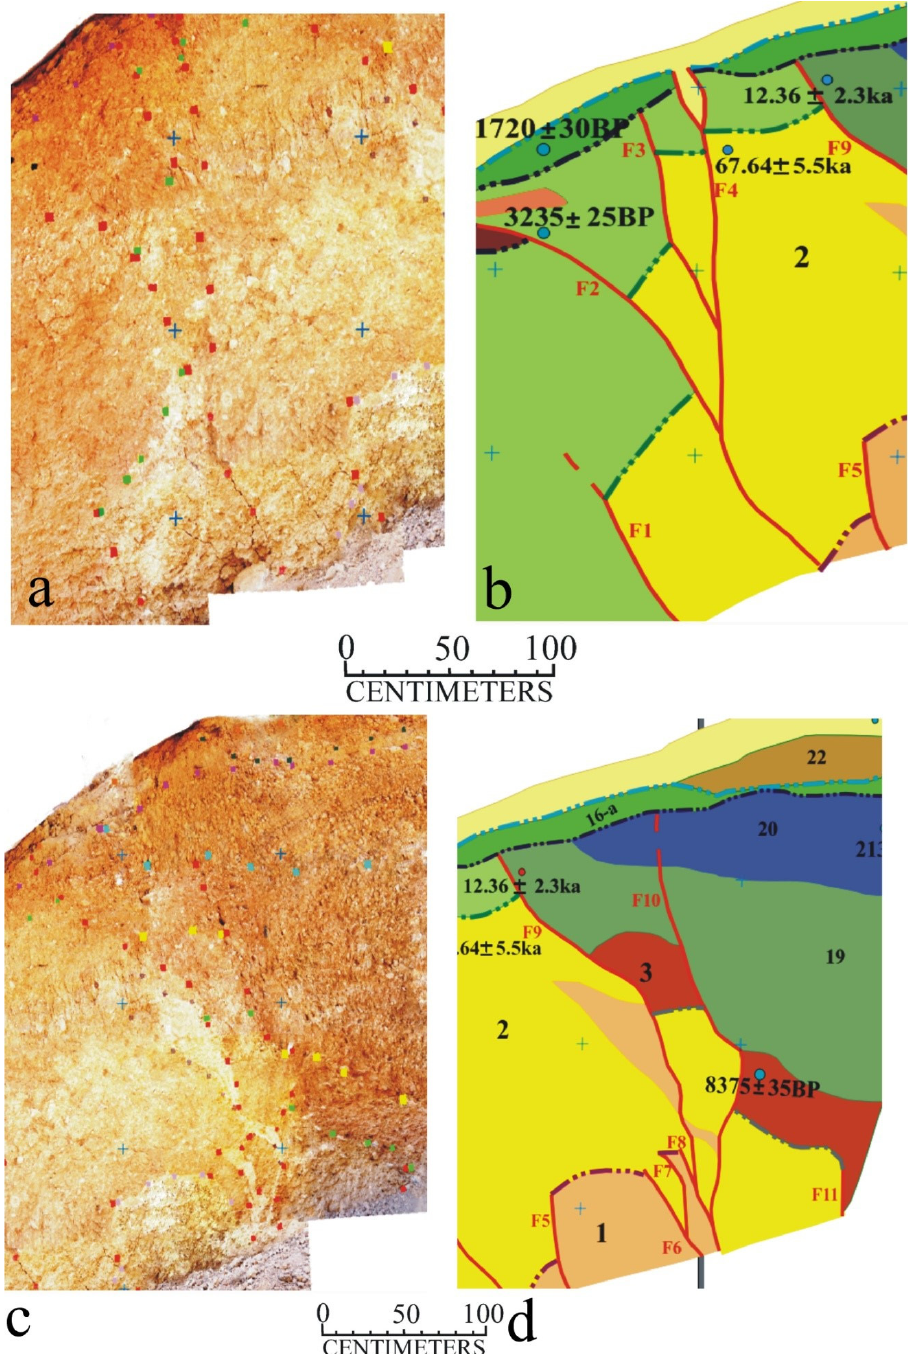
Figure 16. The evidence for the Ev6 event ( a , b ) and the Ev8 and Ev9 events from the fault zone B ( c , d ). ( a , b ) Close-ups showing photomosaic and interpretative sketch of the fault F1 and F3 strands near meters 19 and offsetting units 4, as well as the event horizon (dashed line green), which abruptly terminates upward at the base of the most recent undisturbed deposits (units 16-a and 4). ( c , d ) Close-ups showing photomosaic and interpretative sketch faults F5, F6, F7, F8, F9, F10, and F11 strands near meters 20 and 21 and offsetting units 3 and 2, as well as the event horizons (dashed lines red and gray for base units 3 and 2) which abruptly terminate upward at the base of the most recent undisturbed deposits (units 3 and 2).